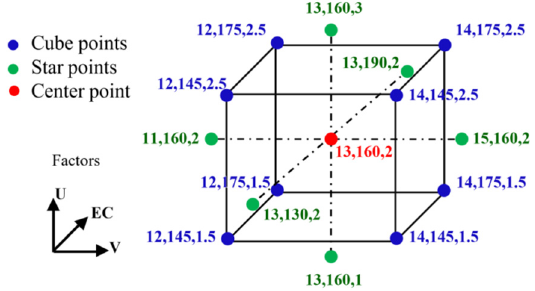
Figure 3. Central composite design for the experimentation.